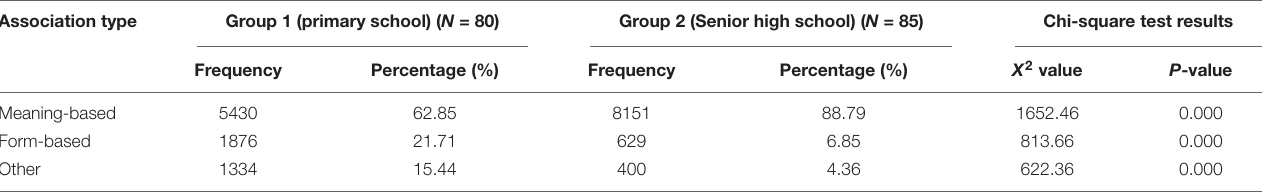
TABLE 3 | The results of word association at the first